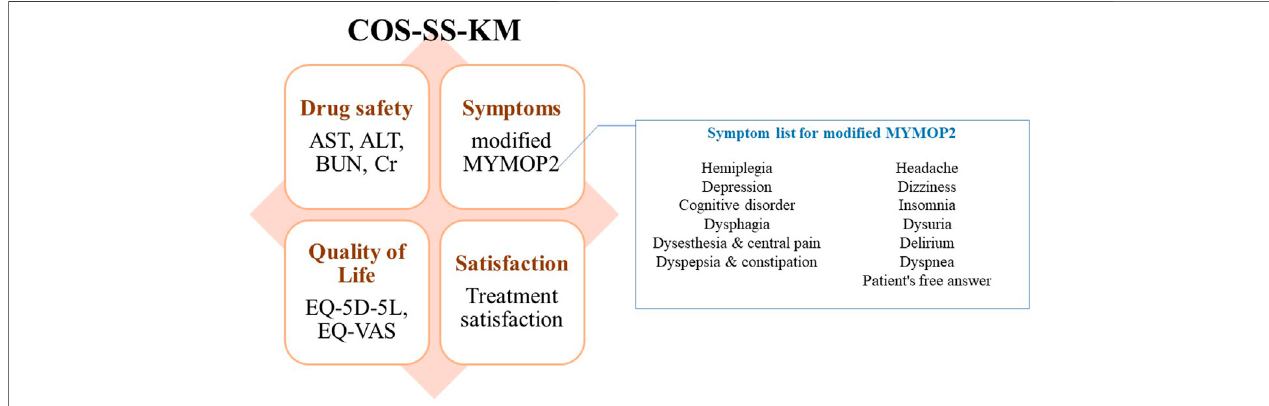
FIGURE2| ConclusionoffortheKoreanMedicineCoreOutcomeSetforStrokeSequelae(COS-SS-KM)development.Eightoutcomescategorizedinsymptoms, drug safety, quality of life, and satisfaction were included in COS-SS-KM. For modi fi ed MYMOP2, symptom list suggested by experts will be used for response convenience.AST,aspartatetransminase;ALT,alaninetransaminase;BUN,bloodureanitrogen;Cr,creatinine;MYMOP2,MeasureYourselfMedicalOutcomePro fi le2; EQ-5D-5L, EuroQol-5-Dimensions-5-Level; EQ-VAS, EuroQol Visual Analogue Scale.